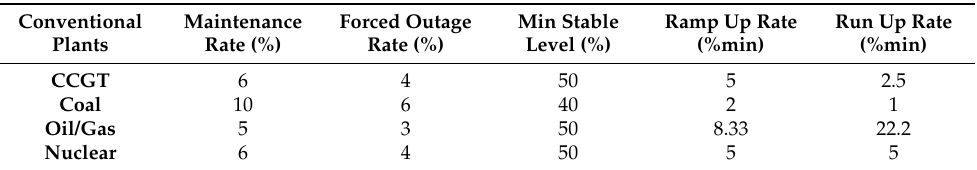
Table 2. Average properties of conventional power plants [32].